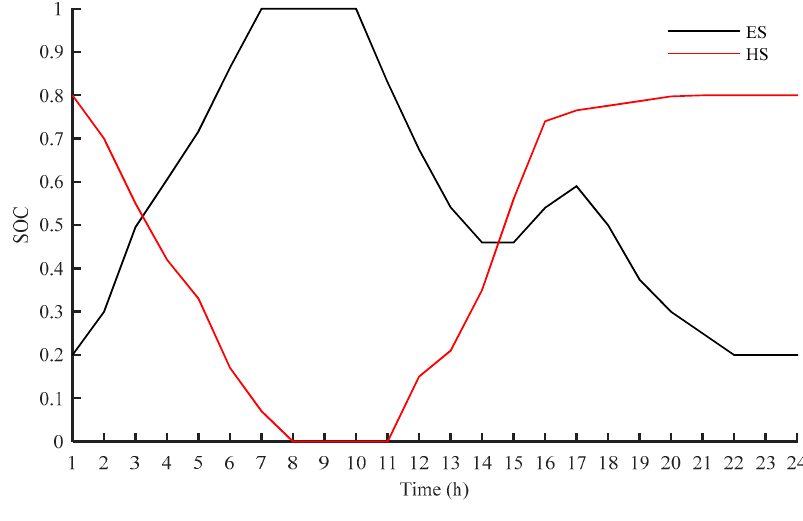
Figure 9. SOCs of ESS in Subcase 1.